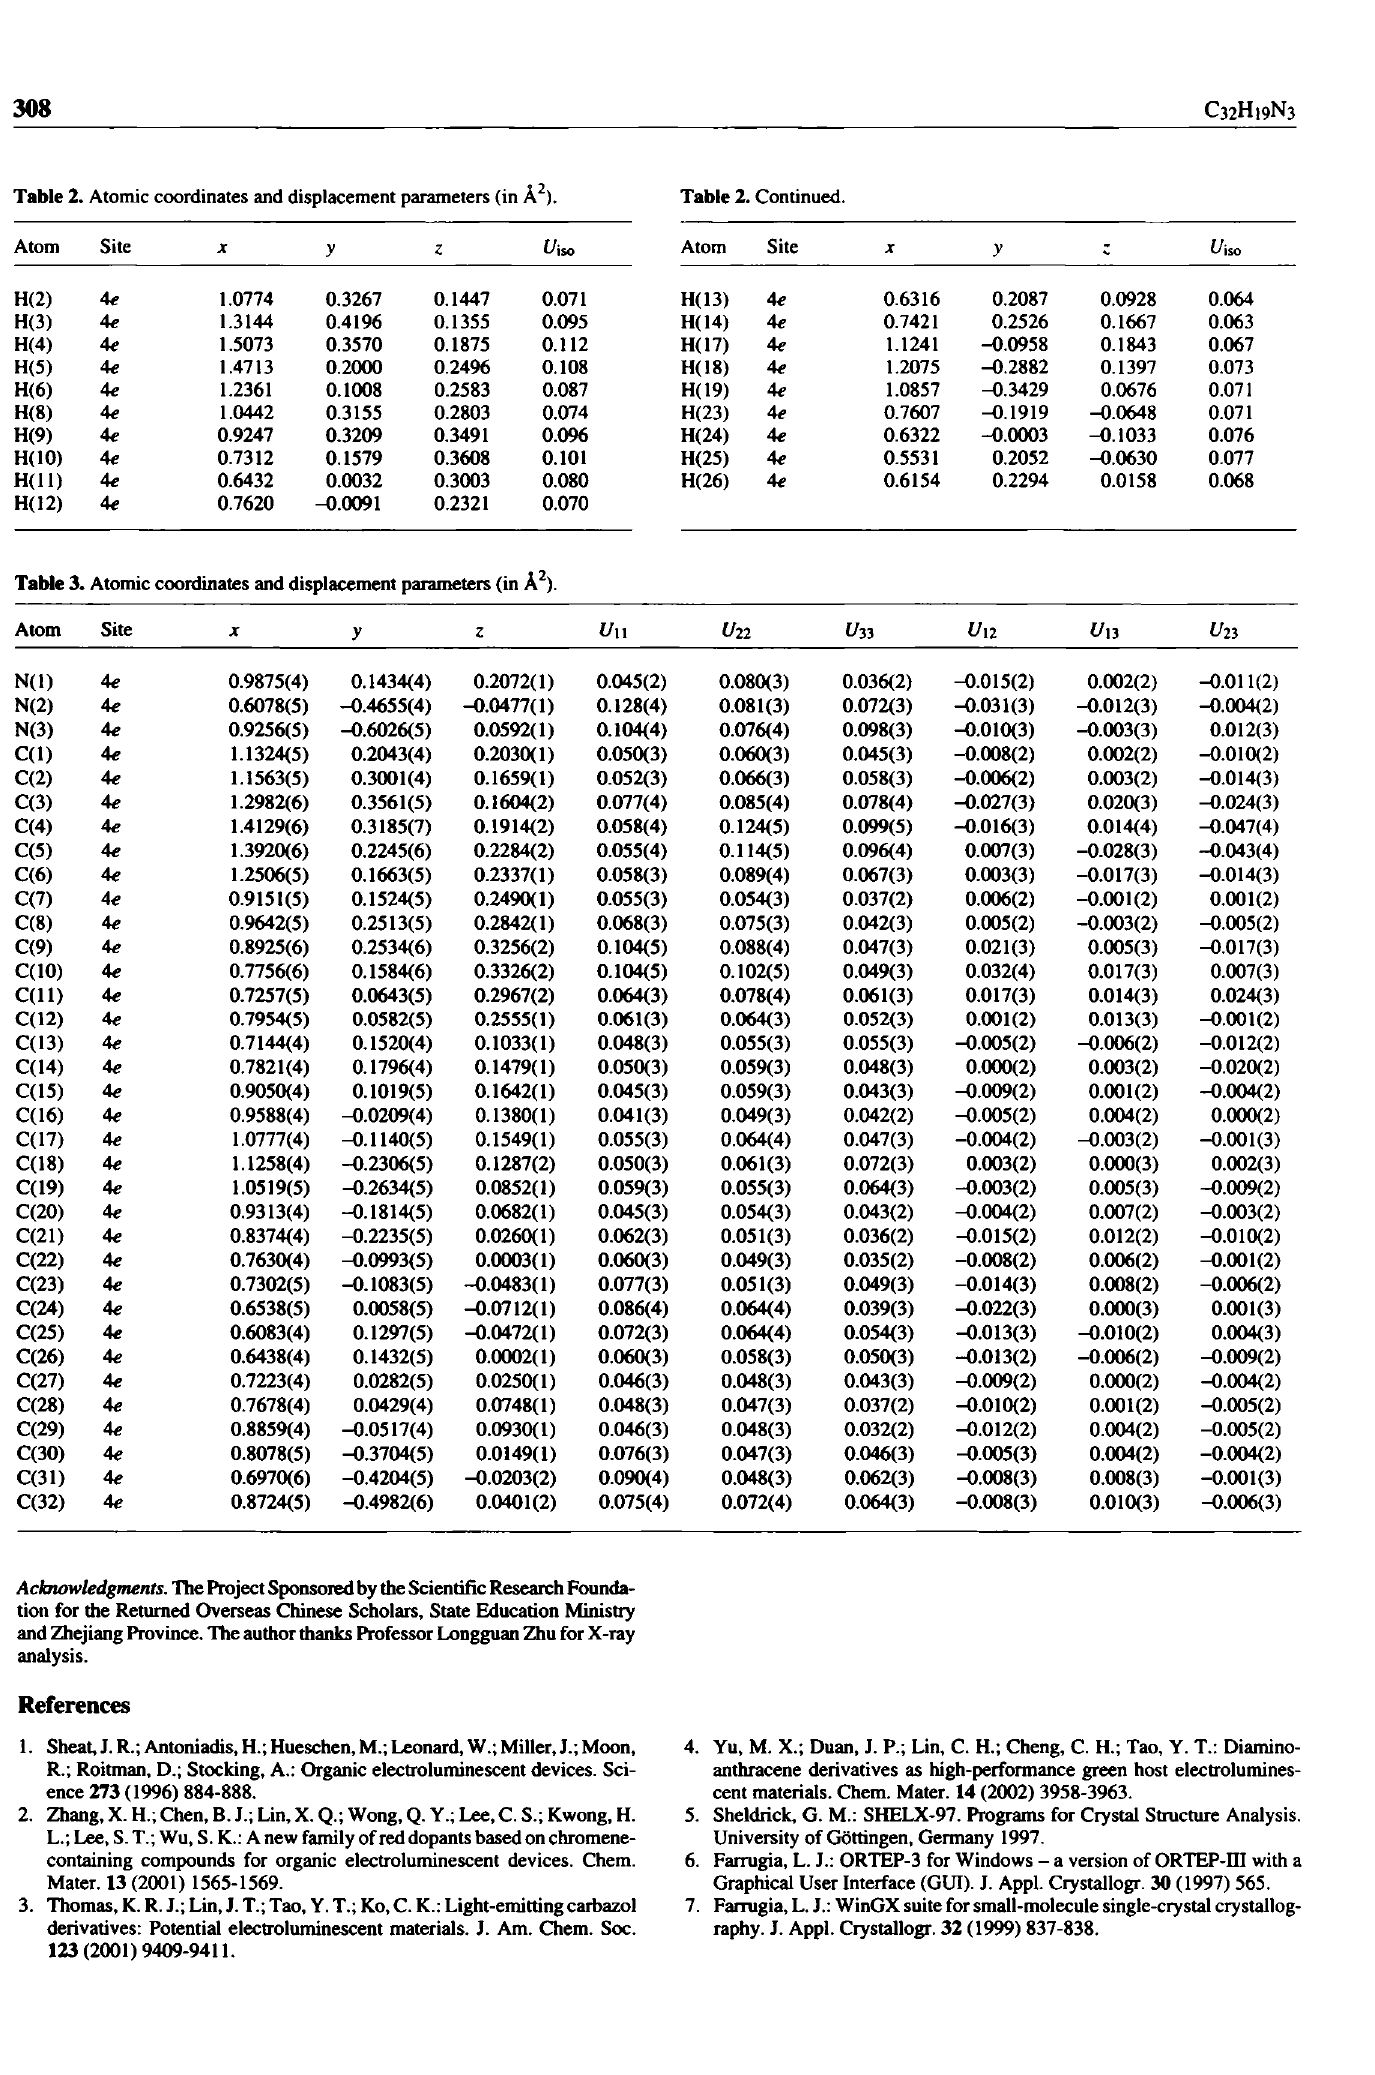
Table 3. Atomic coordinates and displacement parameters (in Â 2